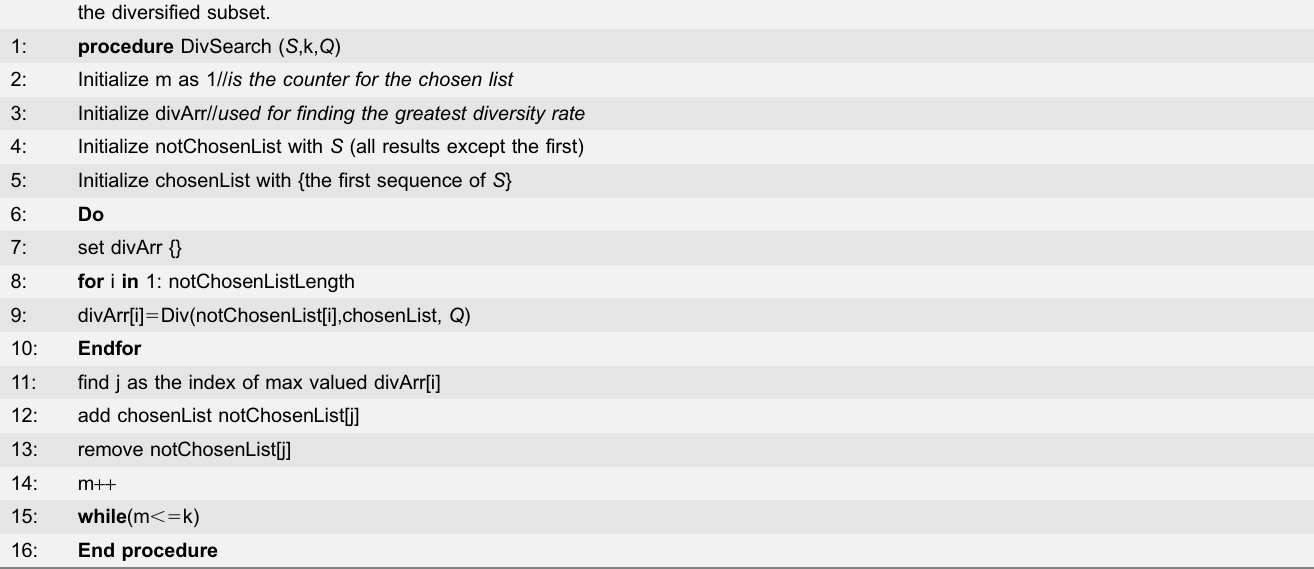
Table 1. DiversitySearch algorithm for a given similar sequence set Inputs : S is the original result set, k is the length of diversified subset from the initial result set and Q is the searched query. Output : chosenList is the diversified